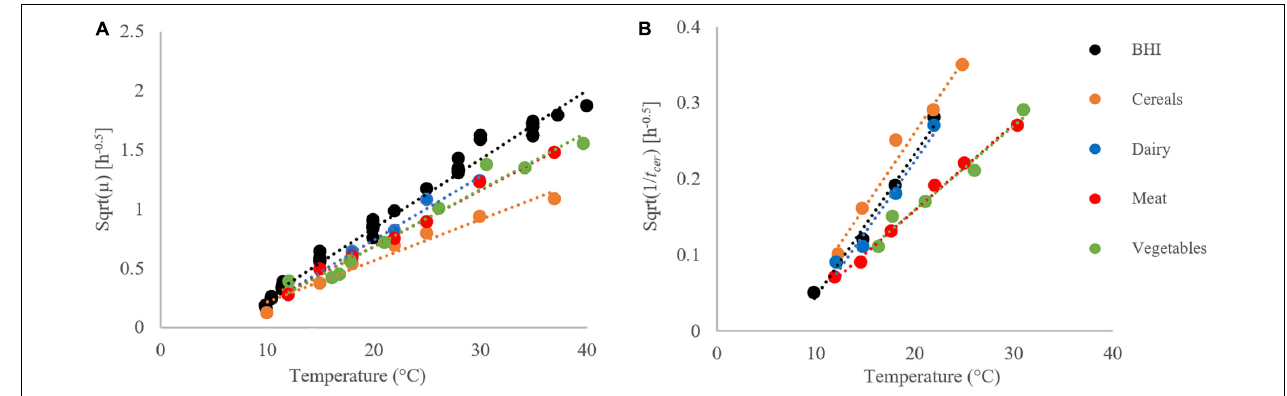
FIGURE 7 | Growth rates (A) and time to first cereulide formation (B) for strain F4810/72 at the sub-optimum temperature range, fitted by the Ratkowsky model. The Square Root (Sqrt) link function was used.